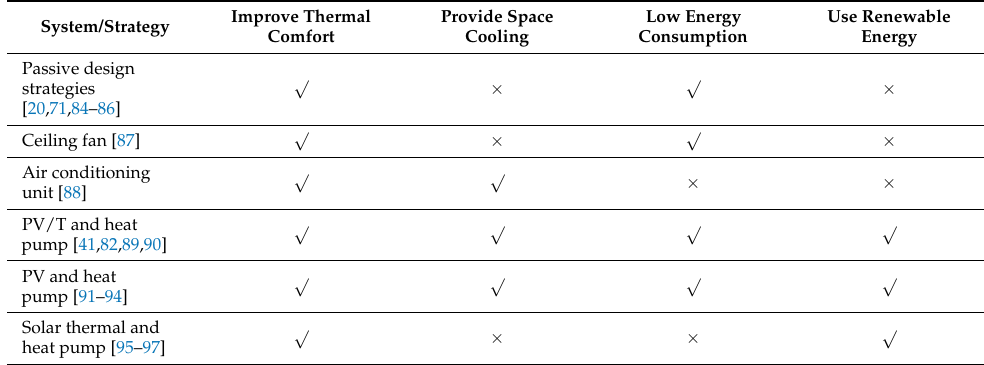
Table 2. System and strategy adopted to improve thermal